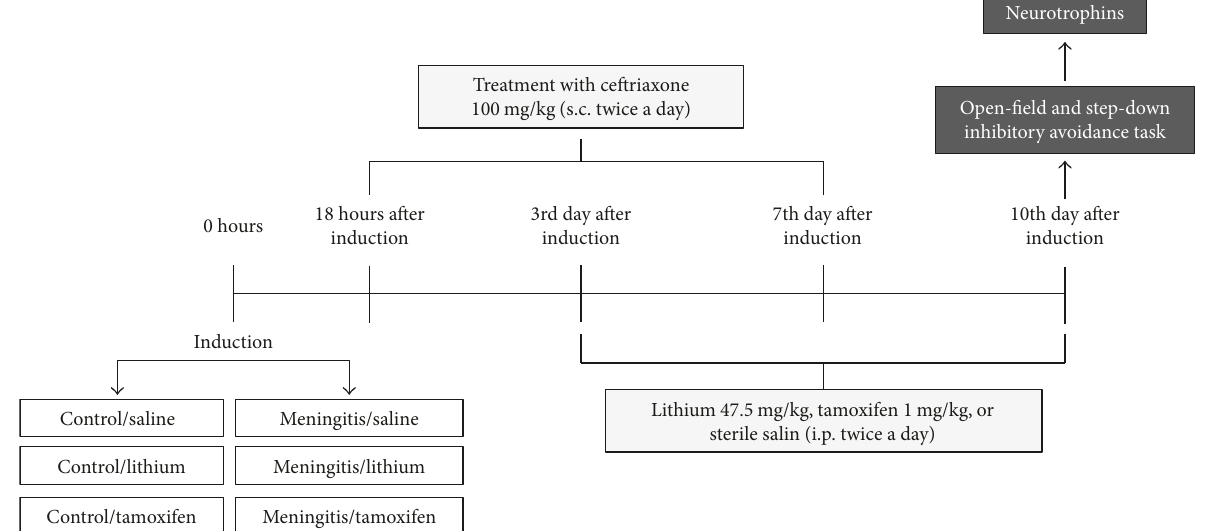
Figure 1: Timeline outline of the induction of meningitis, the adjuvant treatments, and the tests